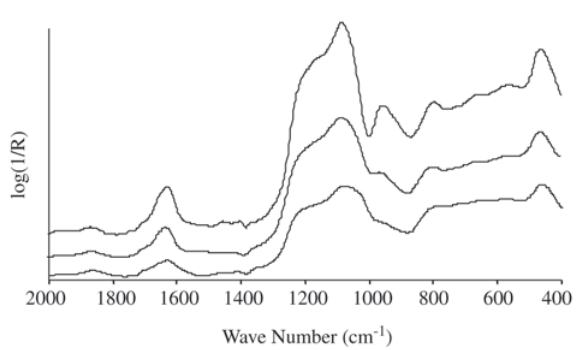
Figure 7. DRFTIR spectra of STD samples treated at 110 °C, 600 °C and 800 °C (top to bottom).